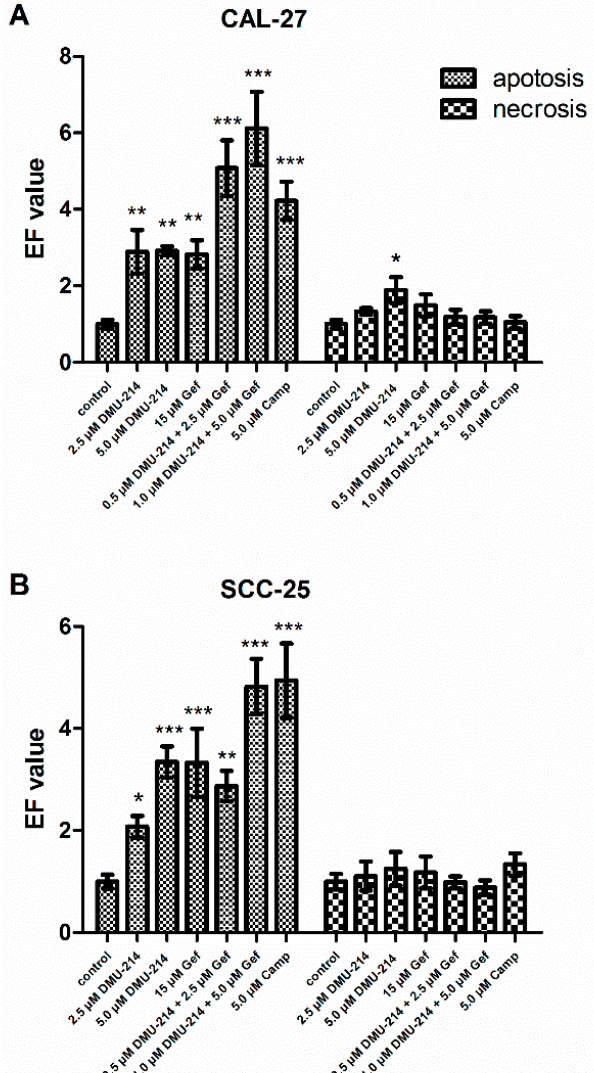
Figure 2. Effect of DMU-214, Gef, and the combination of DMU-214 and Gef on apoptosis and necrosis induction in CAL-27 and SCC-25 cell lines. CAL-27 and SCC-25 cells were treated for 24 h with vehicle, DMU-214 (2.5 µ M and 5.0 µ M), Gef (15 µ M), and the mixtures of both compounds: (i) 0.5 µ M DMU-214 and 2.5 µ M Gef, (ii) 1.0 µ M DMU-214 and 5.0 µ M Gef. Apoptosis and necrosis assay was performed by ELISA test and expressed as an enrichment factor (EF) in CAL-27 ( A ) and SCC-25 ( B ) cell lines. Camptothecin (Camp) was used as a positive control for apoptosis. Results of three independent replicates are presented as mean ± SD. *** p < 0.001, ** p < 0.01, * p < 0.05 indicate a significant difference from the control.